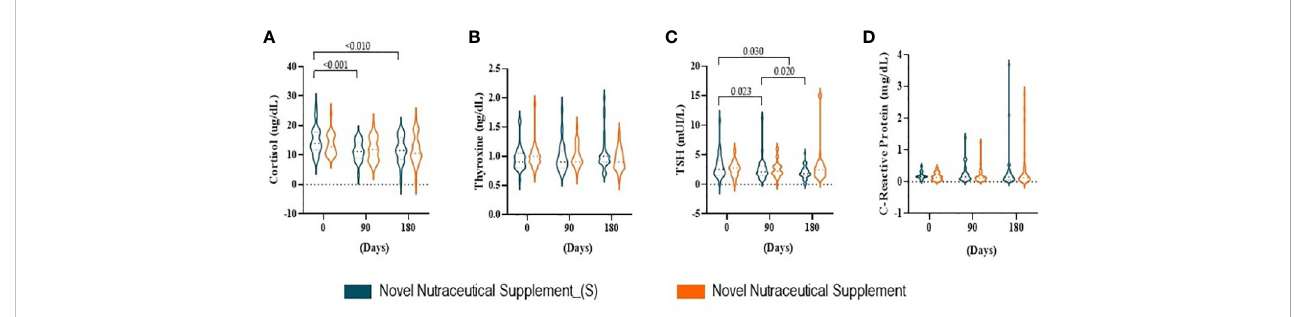
FIGURE 5 Hormones produced by the adrenal and thyroid gland at baseline time (Day 0) and 90 and 180 days post-supplementation. Novel Nutraceutical Supplement_(S) (n = 30) and Novel Nutraceutical Supplement (n = 29). (A) Cortisol. (B) Thyroxine (T4). (C) TSH. (D) C-reactive protein. Values are expressed as mean ± SEM or median (min to max, box plot) by plot violin graphic. TSH, thyroid-stimulating